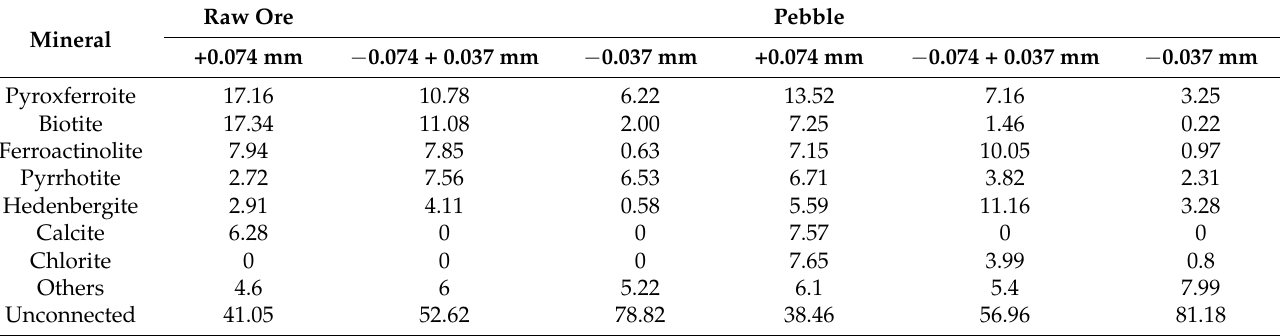
Table 2. The length proportion of cassiterite margins connected with other minerals (%).